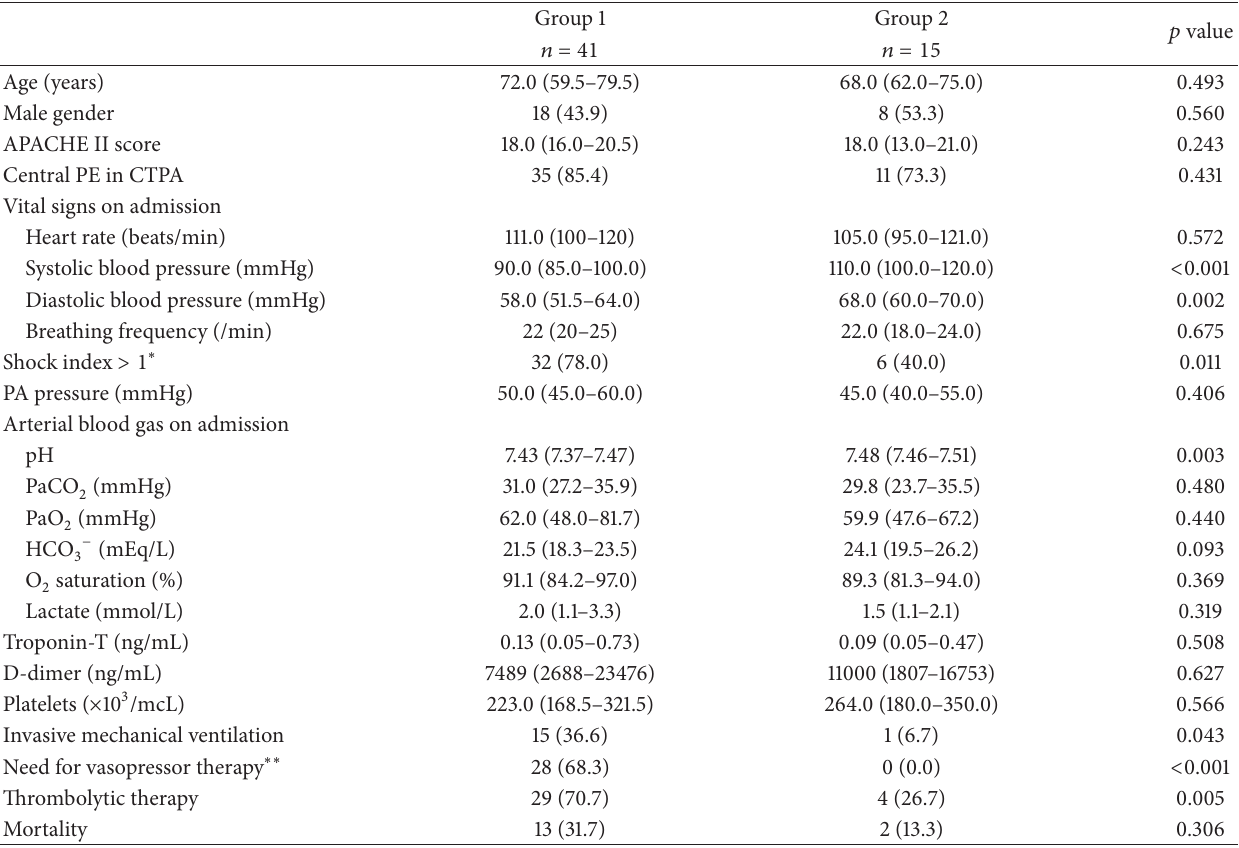
Table 3: Admission clinical parameters of patients according to ESC classification (group 1: high-risk; group 2: intermediate- and